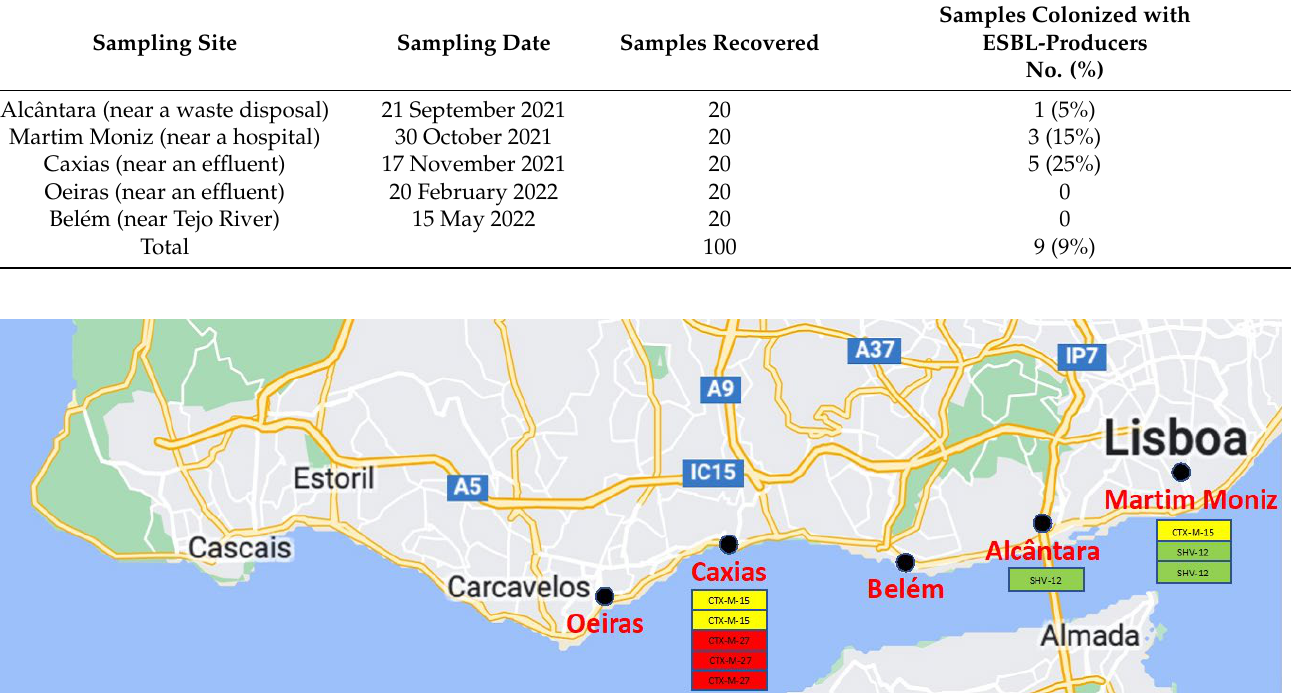
Figure 1. Map depicting the different sampling sites and the detected ESBLs.